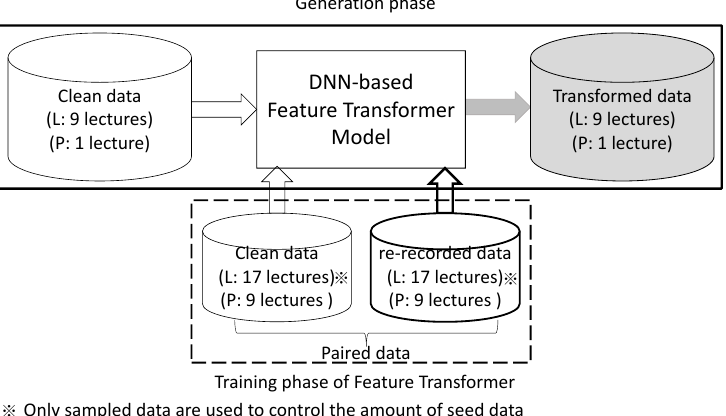
Figure 6. Training of DNN-based feature transformer